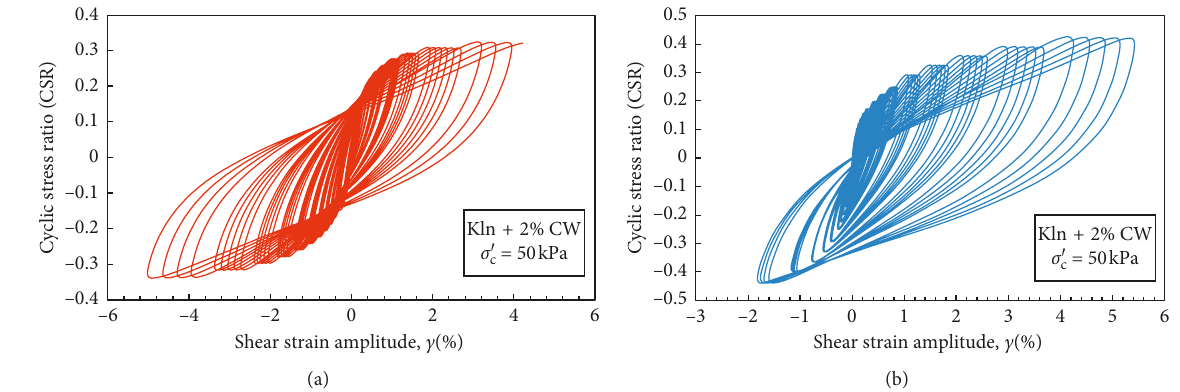
Figure 5: Hysteresis loops of samples with 2% CW added: (a) Kln +2% CW; (b) Mnt+2% CW.